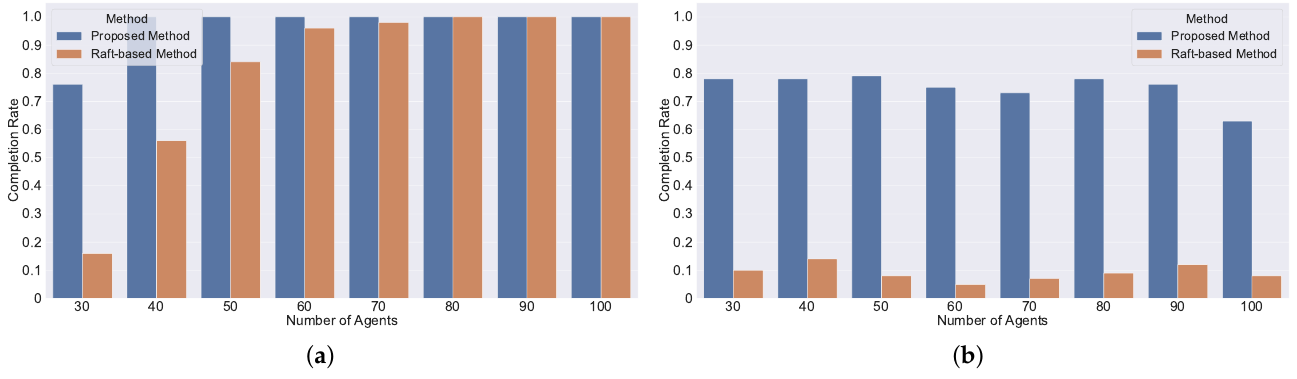
Figure 10. The election completion rate over the number of follower agents (the higher the better). ( a ) The comparison between two methods with threshold of 15-vote in 400 units communication range. ( b ) The comparison between two methods with threshold of half swarm size in 400 units communication